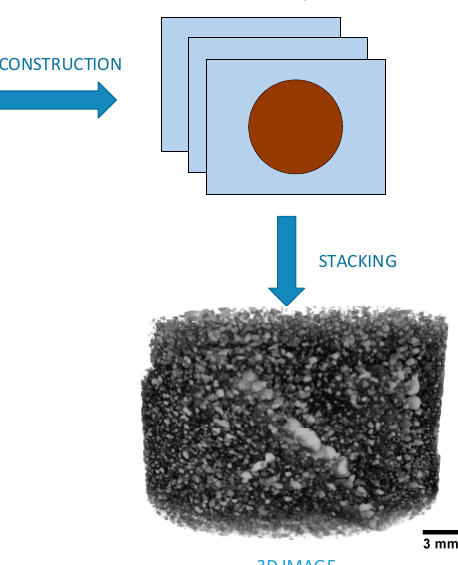
Figure 2. Specimen analysis and data acquisition using µCT. The X-ray beam originates from a small focal spot and illuminates a planar detector. The specimen is fixed in a stage, and rotated to obtain several projections over a range of angles and positions. The 2D image slices are reconstructed from these projections, whereas afterwards it can be stacked and rendered to create the 3D volume for displaying purposes.